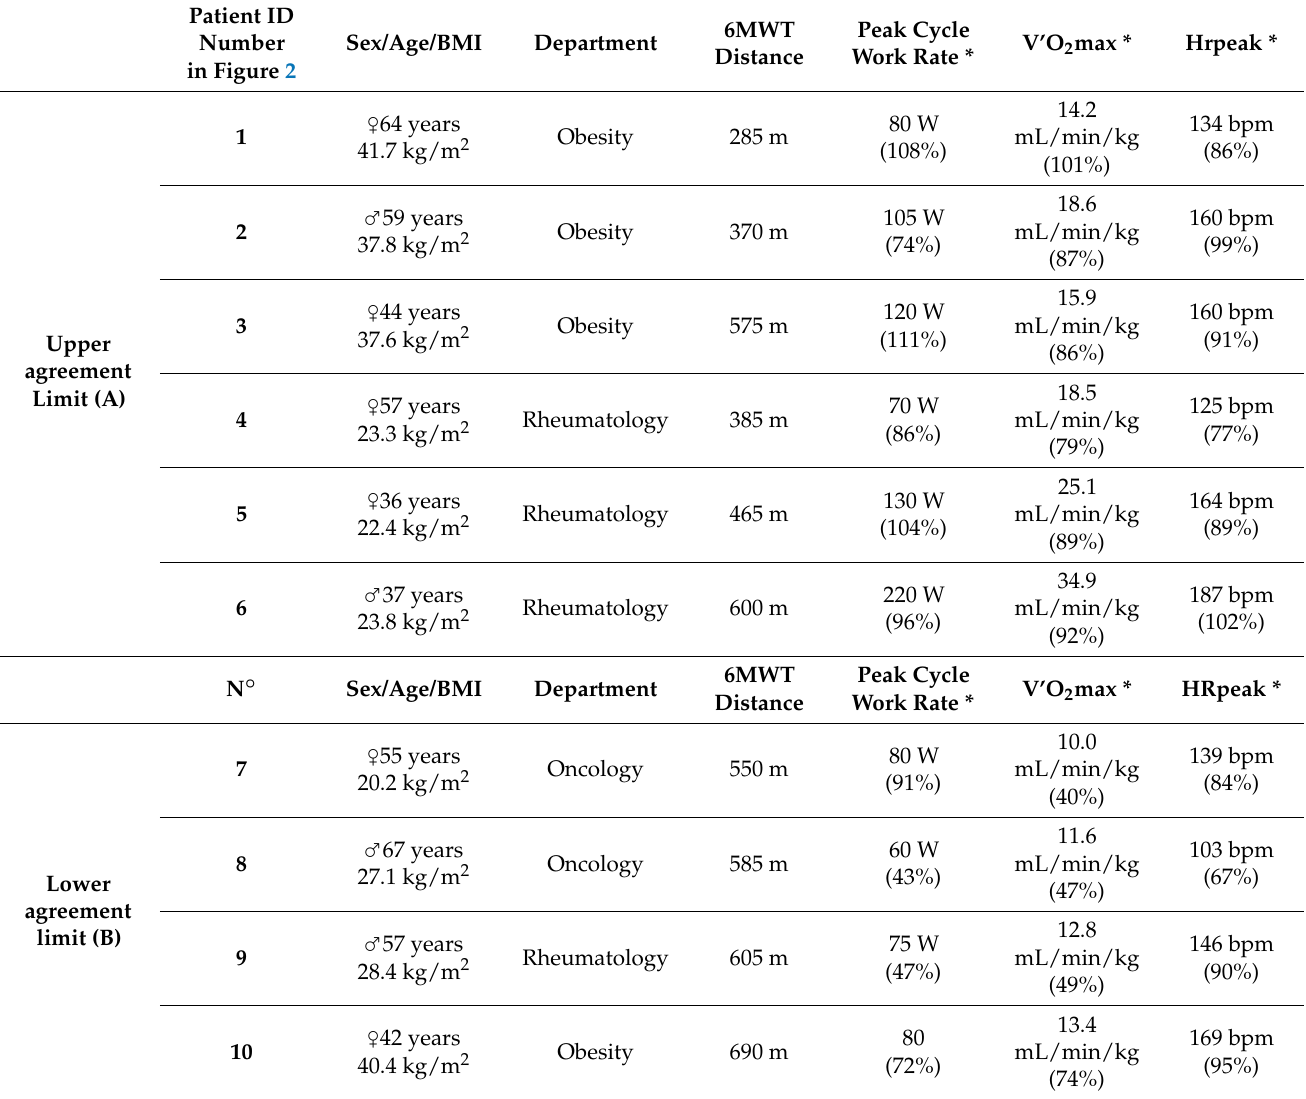
Table 2. Characteristics of the 10 patients who exceeded the upper (A) and lower (B) agreement limit in the Bland–Altman plot (Figure 2) and thus have considerably higher maximal oxygen uptake (V’O 2 max) than 6-Minute Walk Test (6MWT)